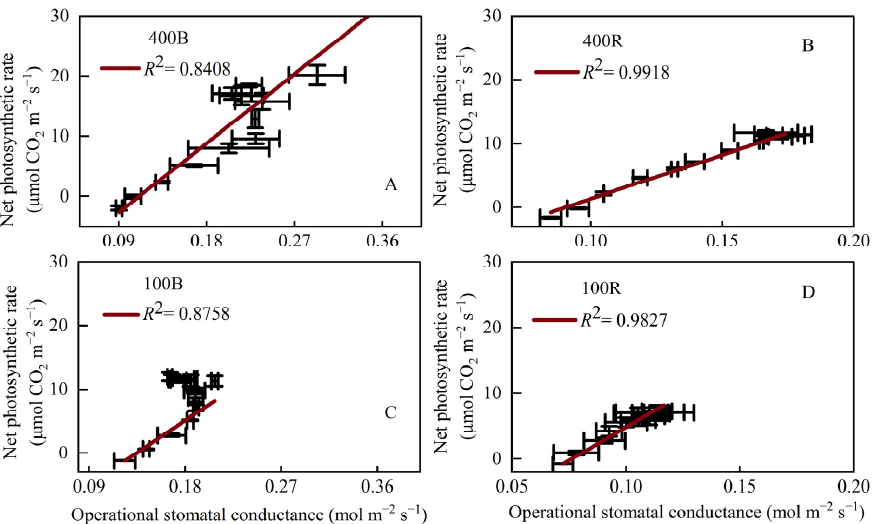
Figure 5. The correlation of net photosynthetic rate and operational stomatal conductance (g op ). ( A ) 400 B; ( B ) 400 R; ( C ) 100 B; ( D ) 100 R. 400 B and 100 B denote the blue light with 400 µmol m − 2 s − 1 and 100 µmol m − 2 s − 1 , respectively. 400 R and 100 R denote the red light with 400 µmol m − 2 s − 1 and 100 µmol m − 2 s − 1 , respectively. Values represent the mean of three replicates. The bars represent the standard error.